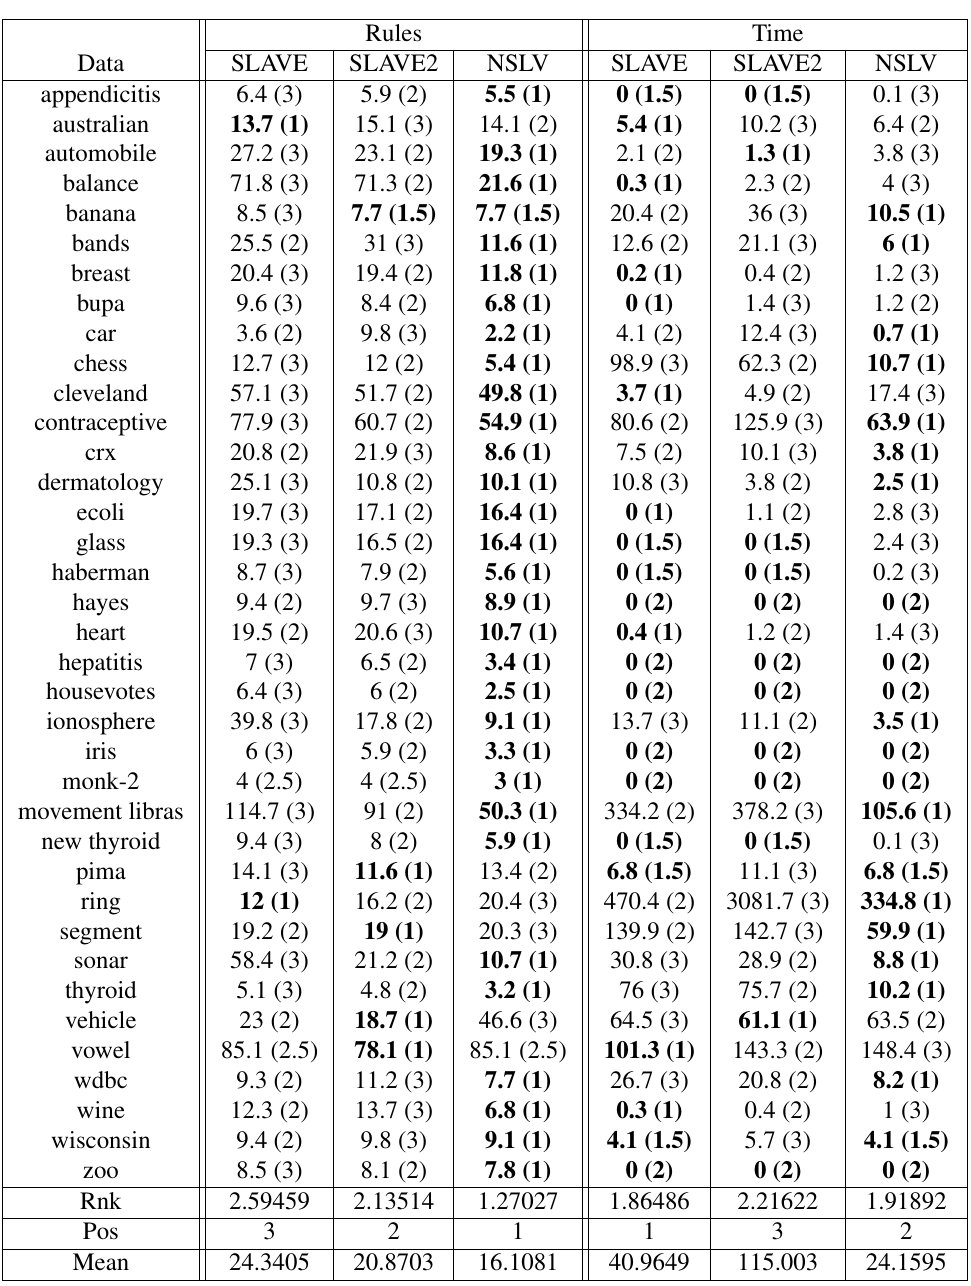
Table 6. Results obtained by SLAVE, SLAVE2 and NSLV on 37 databases. The Table shows the average number of rules per database and the time needed to get the